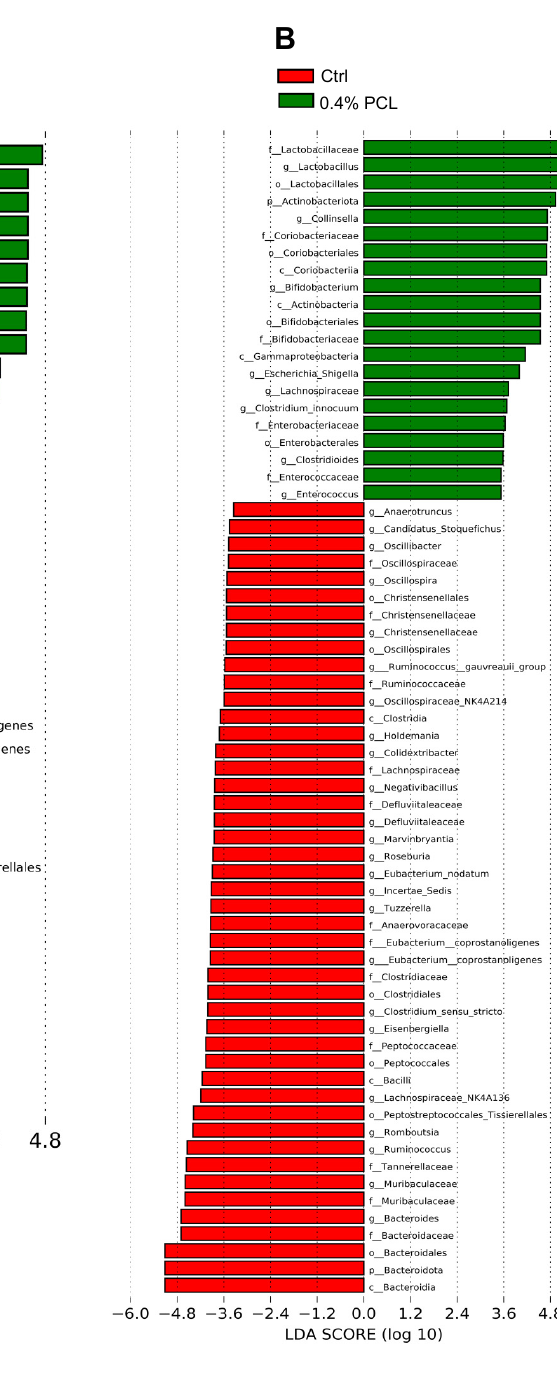
Figure 2. Different bacterial taxa between the Ctrl and 0.2% PCL groups ( A ) or between the Ctrl and 0.4% PCL groups ( B ) (LEfSe analysis). The two-tailed nonparametric Kruskal–Wallis test was used to evaluate the significance of differences in taxa at p <